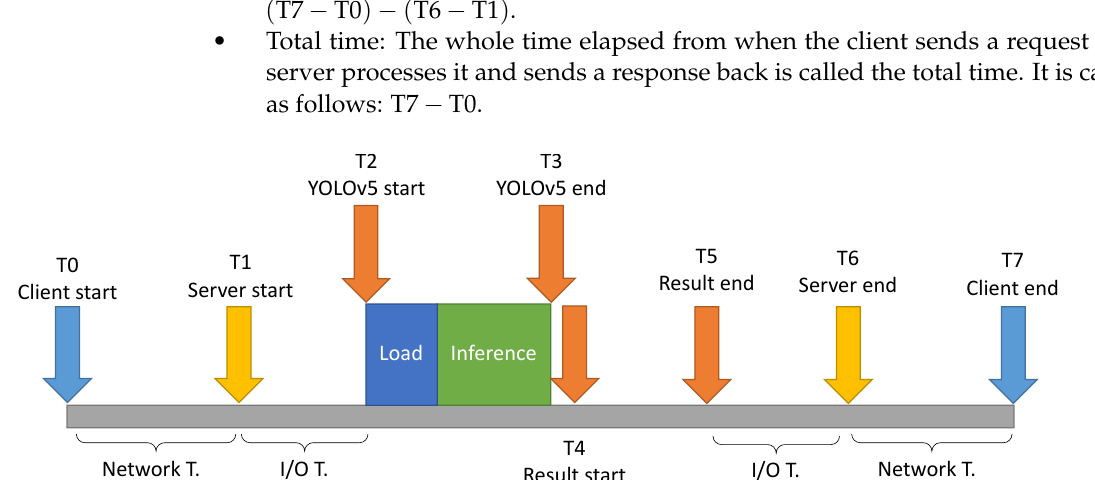
Figure 8. Times taken in different stages to carry out the service. Load time, inference time, results time, input/output time, and network time.